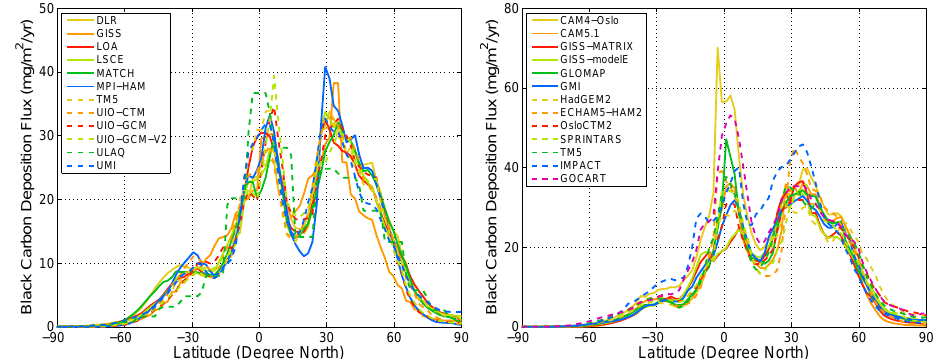
Fig. 6. Annual, zonal-mean black carbon deposition fluxes for phase I (left panel) and phase II (right panel) models. (Note the scale on ordinate is different for the two plots.)